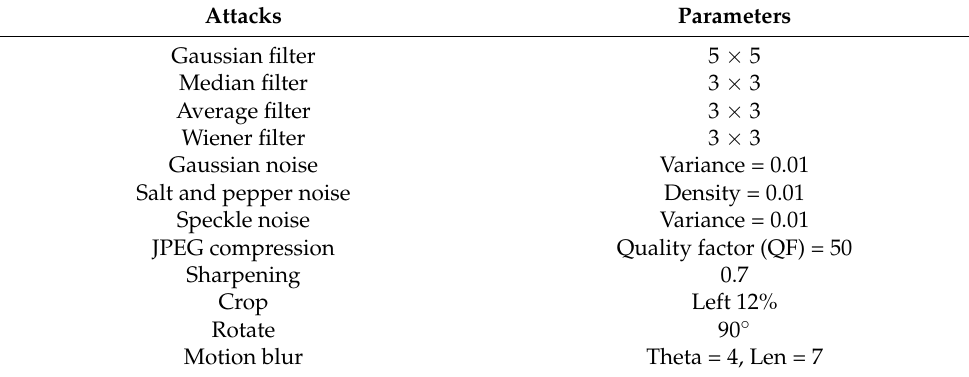
Table 1. Parameters of attacks.